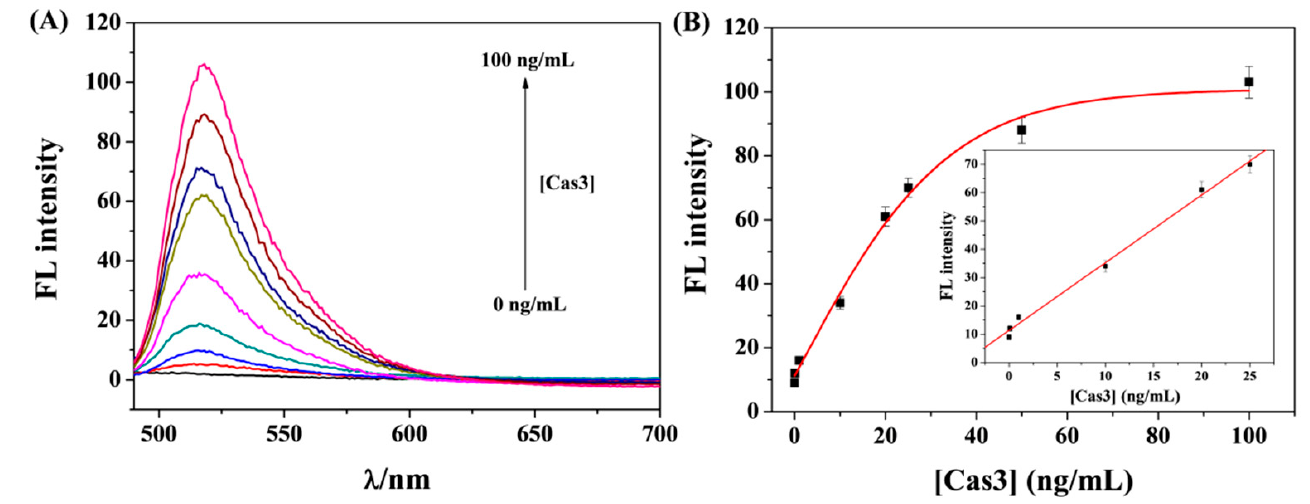
Figure 3. ( A ) Fluorescence spectra for the assays of various concentrations of Cas3 (from bottom to top: 0, 0.01, 0.1, 1, 10, 20, 25, 50 and 100 ng/mL). ( B ) Calibration curve between fluorescence intensity and Cas concentration. Table 1. Analytical performances of nanomaterial-based fluorescence assays of Cas3.